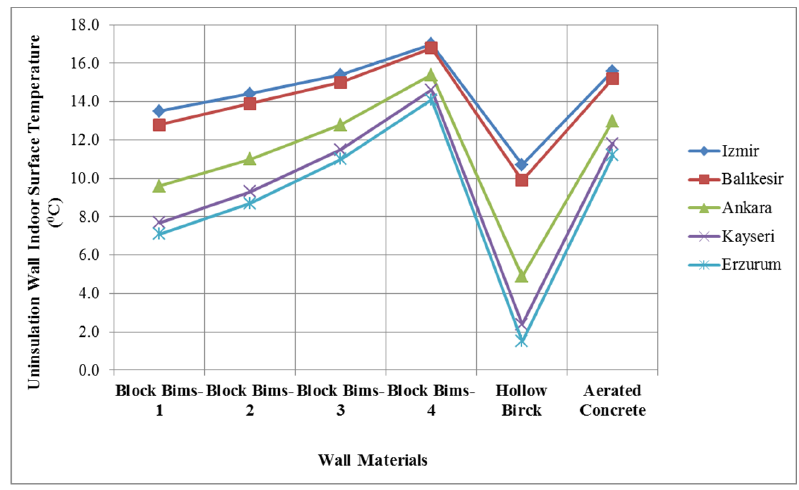
Figure 8. Indoor surface wall temperature values due to different uninsulated wall materials.